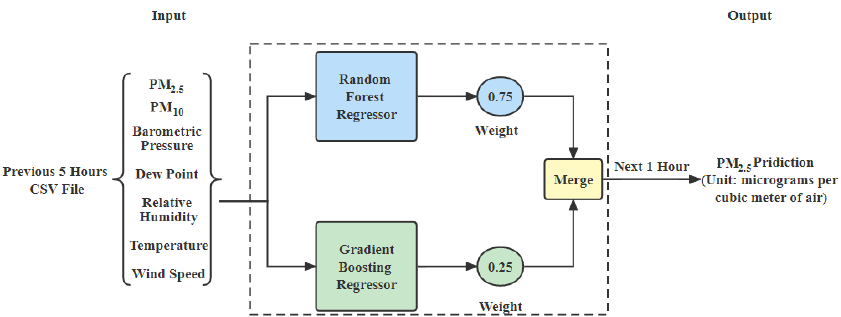
Figure 2. An ensemble model of the weighted average method for hourly 𝑃𝑀 2.5 prediction (created by author).